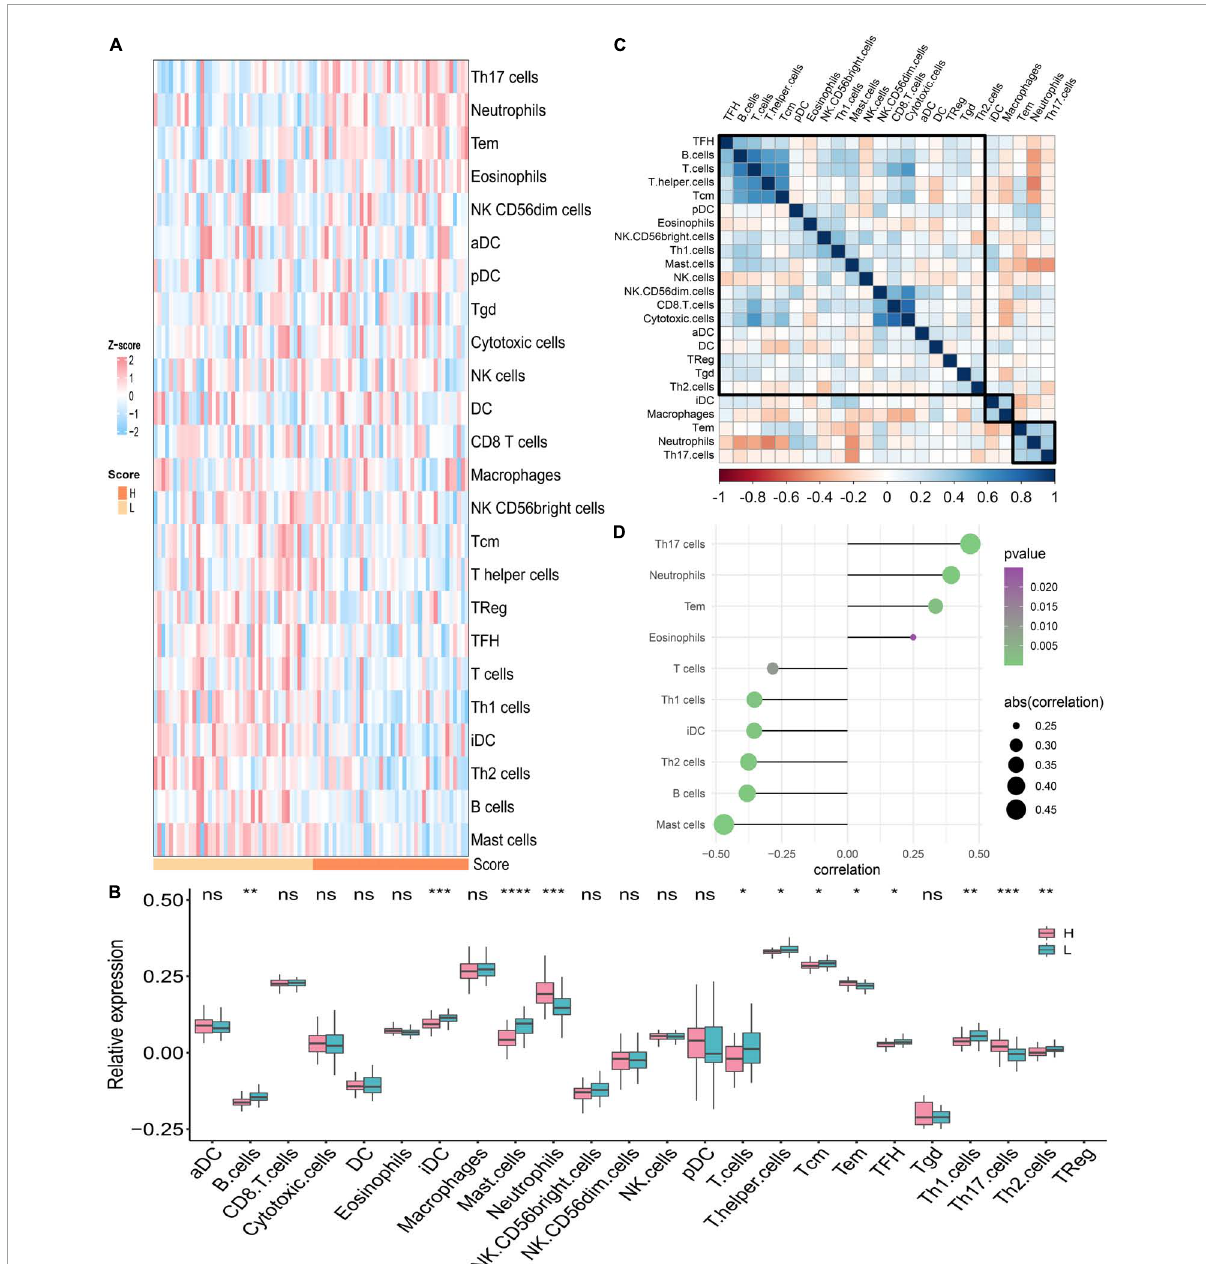
FIGURE8 Analysis of immune landscape associated with PAH. (A) The heatmap of the immune infiltration in high- and low-score groups. (B) The boxplot of the 24-type immune infiltration in high- and low-score groups. * P < 0.05, ** P < 0.01, and *** P < 0.001. (C) The heatmap of the correlations between different immune cells. (D) Relationship between the PDS score and immune infiltration. H: high score; L: low score. aDC: activated dendritic cell; DC: dendritic cell; iDC: interdigitating cell; NK cells: natural killer cells; pDC: plasmacytoid dendritic cells; Tcm: central memory T cell; Tem: effector memory T cell; TFH: T follicular helper cell; Tgd: gamma delta T cells; TReg: T regulatory